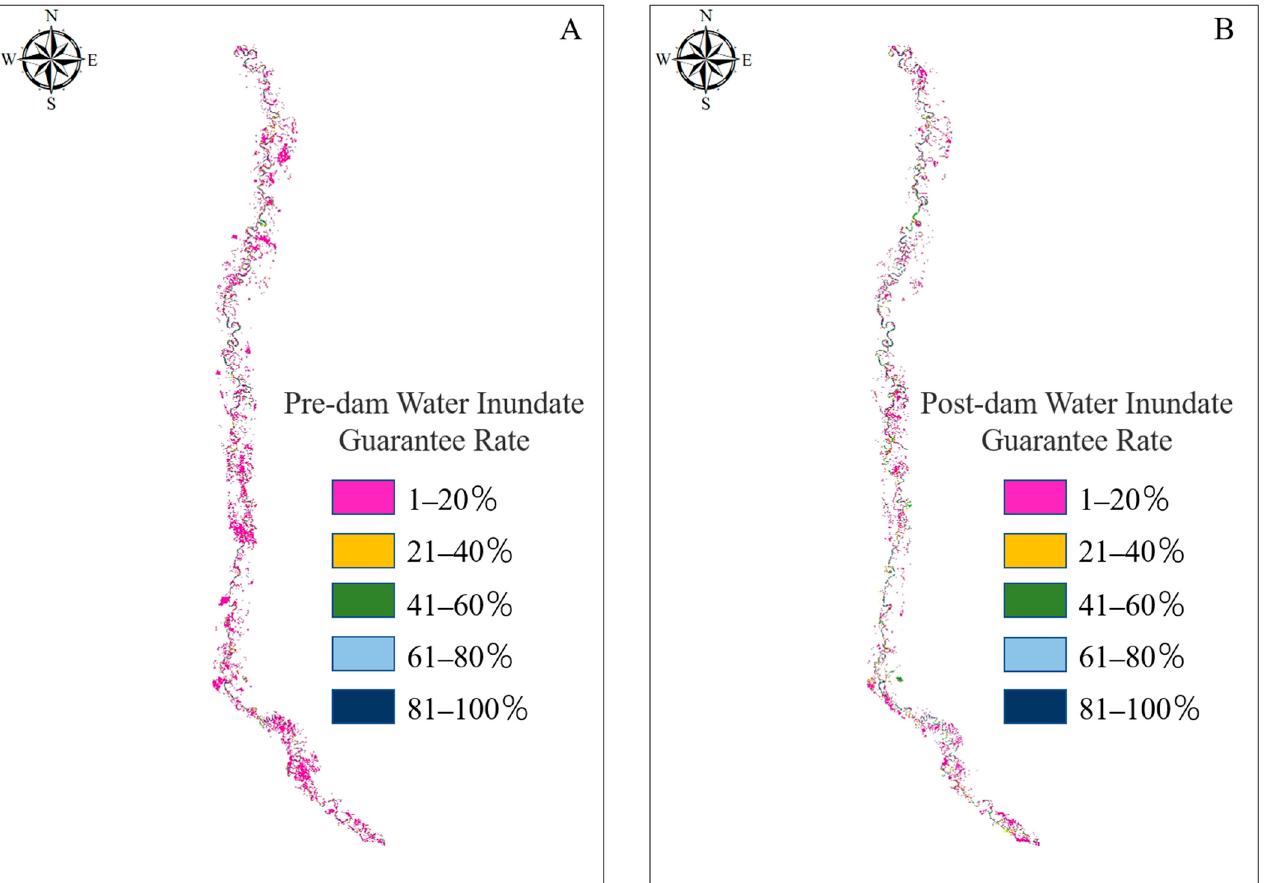
Figure 3. Statistical diagram of WIGR distribution in the study area (( A ) pre-dam construction; ( B ) post-dam construction). Table 4. Area statistics for different WIGR values before and after dam construction [25]. Pre-Dam WIGR (%)